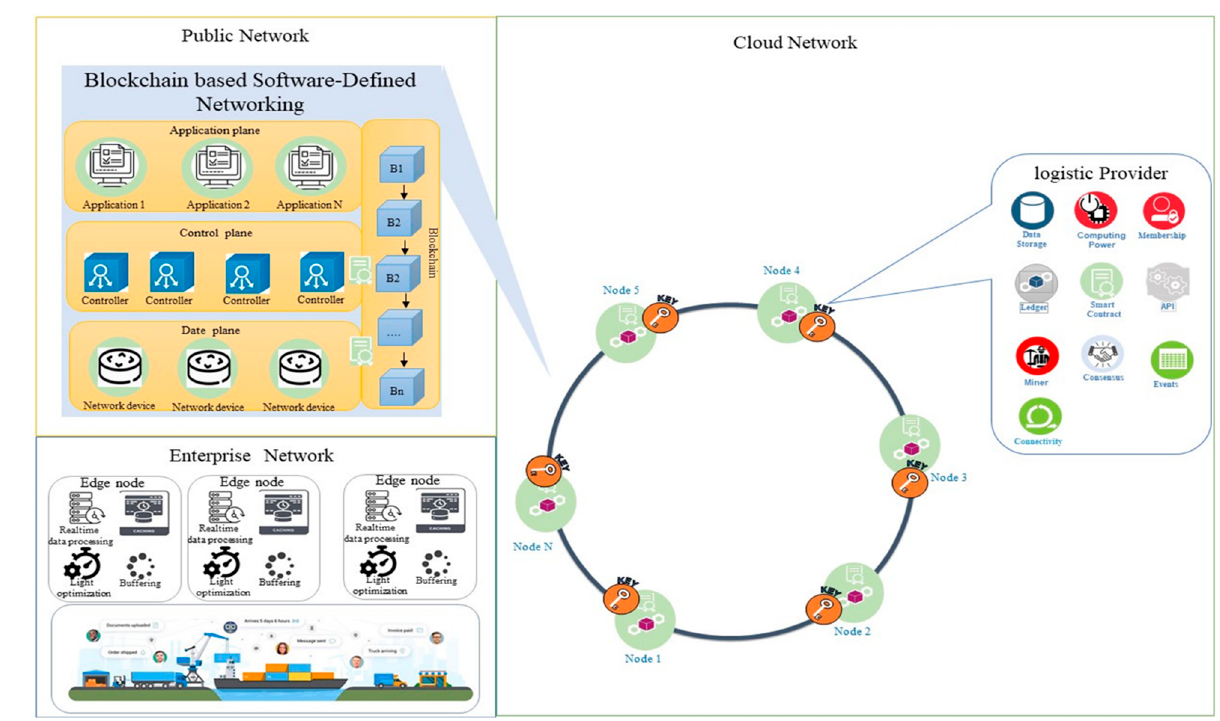
Figure 2. Component diagram and network specification of OL .